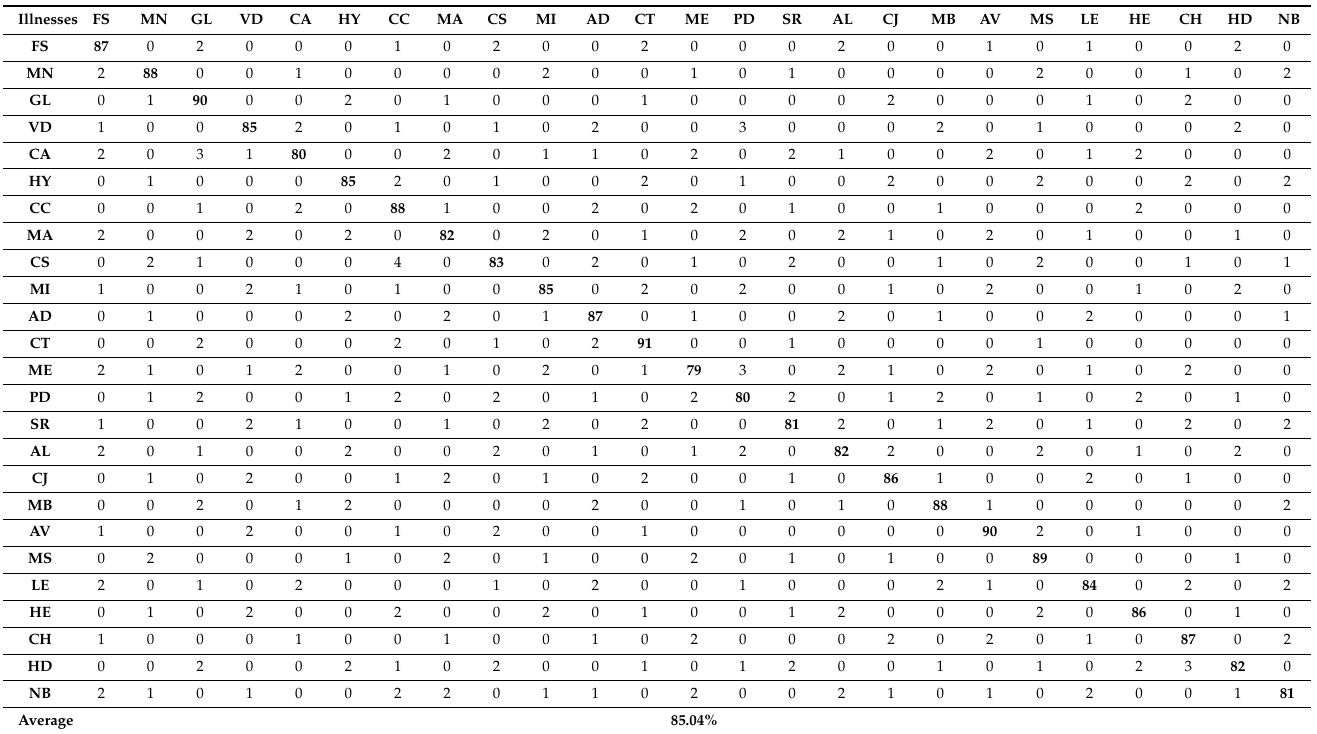
Table 2. Performance of Speeded Up Robust Features (SURF) method (instead of using the developed approach) using MRI dataset (Unit %).